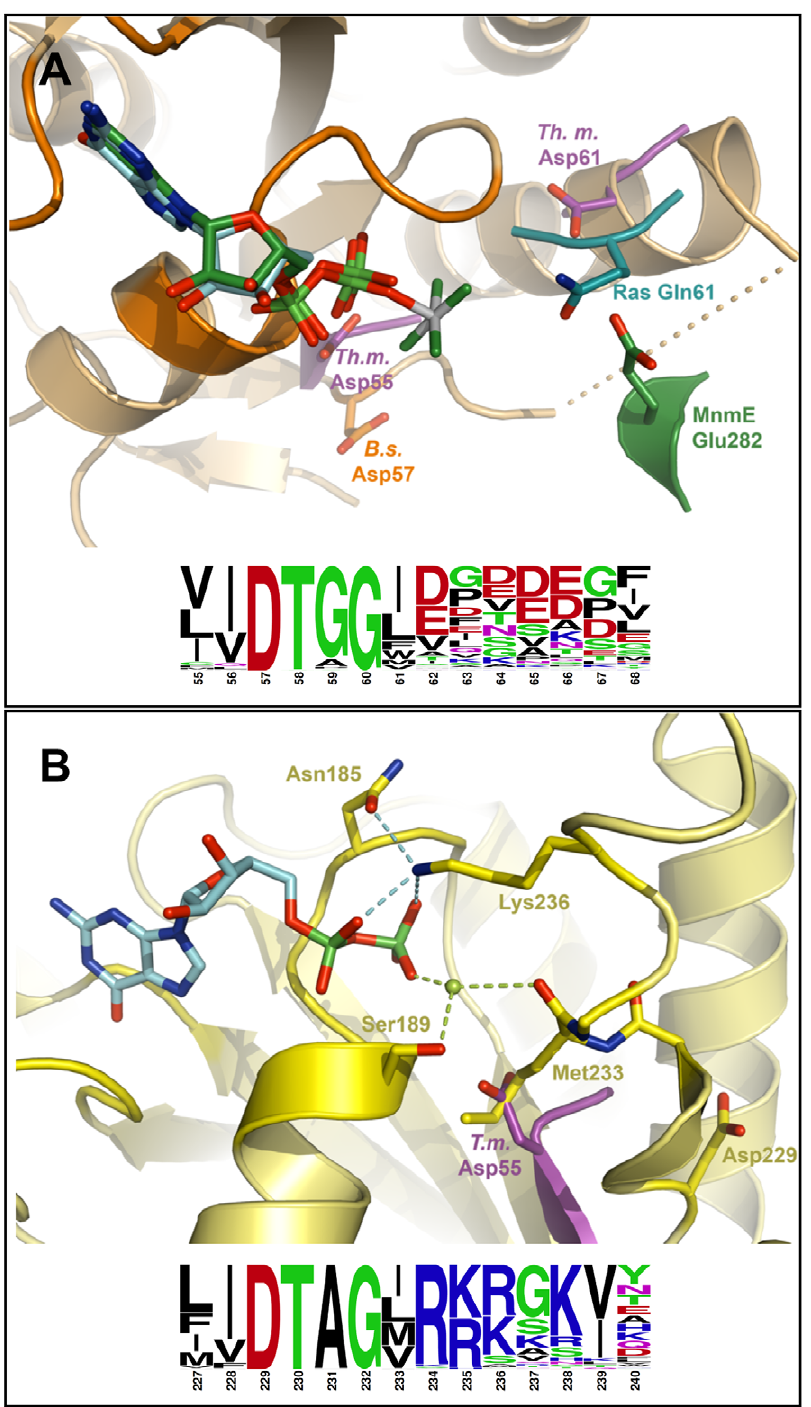
Figure 8. Superimposition of GD1 or GD2 domains and sequence conservation in the switch 2 motifs. A , the EngA GD1 domain is depicted in orange and the GDP molecule in cyan. Gln61 from hRas is shown in turquoise, MnmE Glu282 and GDP-AlFx transition state analogue are shown in green. T. maritima EngA Asp55 and Asp61 are shown in purple. Structure superpositions were performed by superimposition of the G1, G4 and G5 motifs using PyMol. B , the EngA GD2 domain is depicted in yellow with its bound GDP molecule shown in cyan. T. maritima EngA Asp55 is shown in purple. Putative Mg 2 + position, as obtained from the superposed MnmE structure, is shown in pale green. Hydrogen bonds are depicted with cyan dashed lines. Structure superpositions were performed by superimposition of the G1, G4 and G5 motifs. One hundred EngA sequences were used to show the sequence variation in the switch 2 following the G3 motif and using the WebLogo server (http://weblogo.berkeley.edu/).